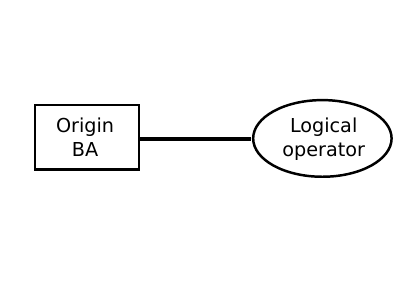
Figure 2.22: The Activity Flow glyph for logic arc . BA = biological activity